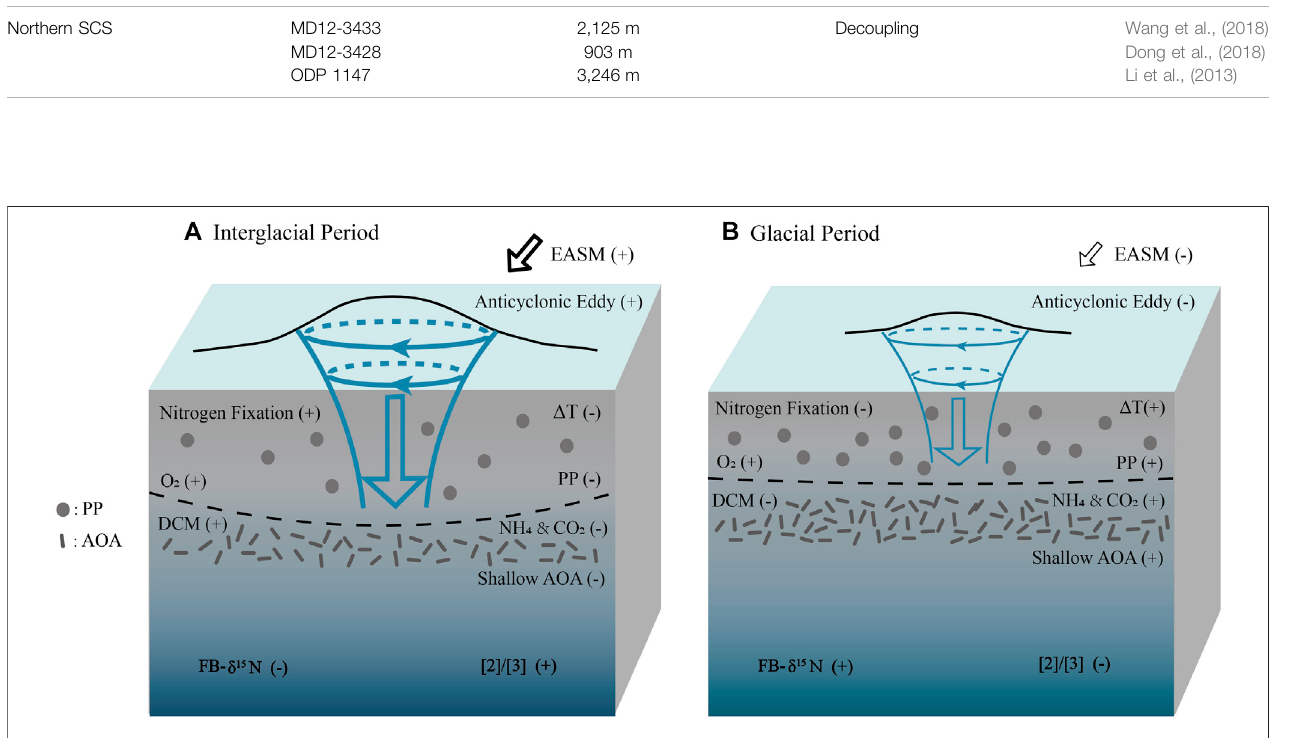
FIGURE 4 | Mechanisms of the relationship between ammonia oxidation and nitrogen fi xation in upper waters of the northern SCS since 30 ka. (A) During the interglacial period, EASM induced the formation of anticyclonic eddies which shifted the halocline downward. (B) During the glacial period, weaker EASM reduced the anticyclonic eddies activity and lifted the halocline. PP denotes the primary productivity.